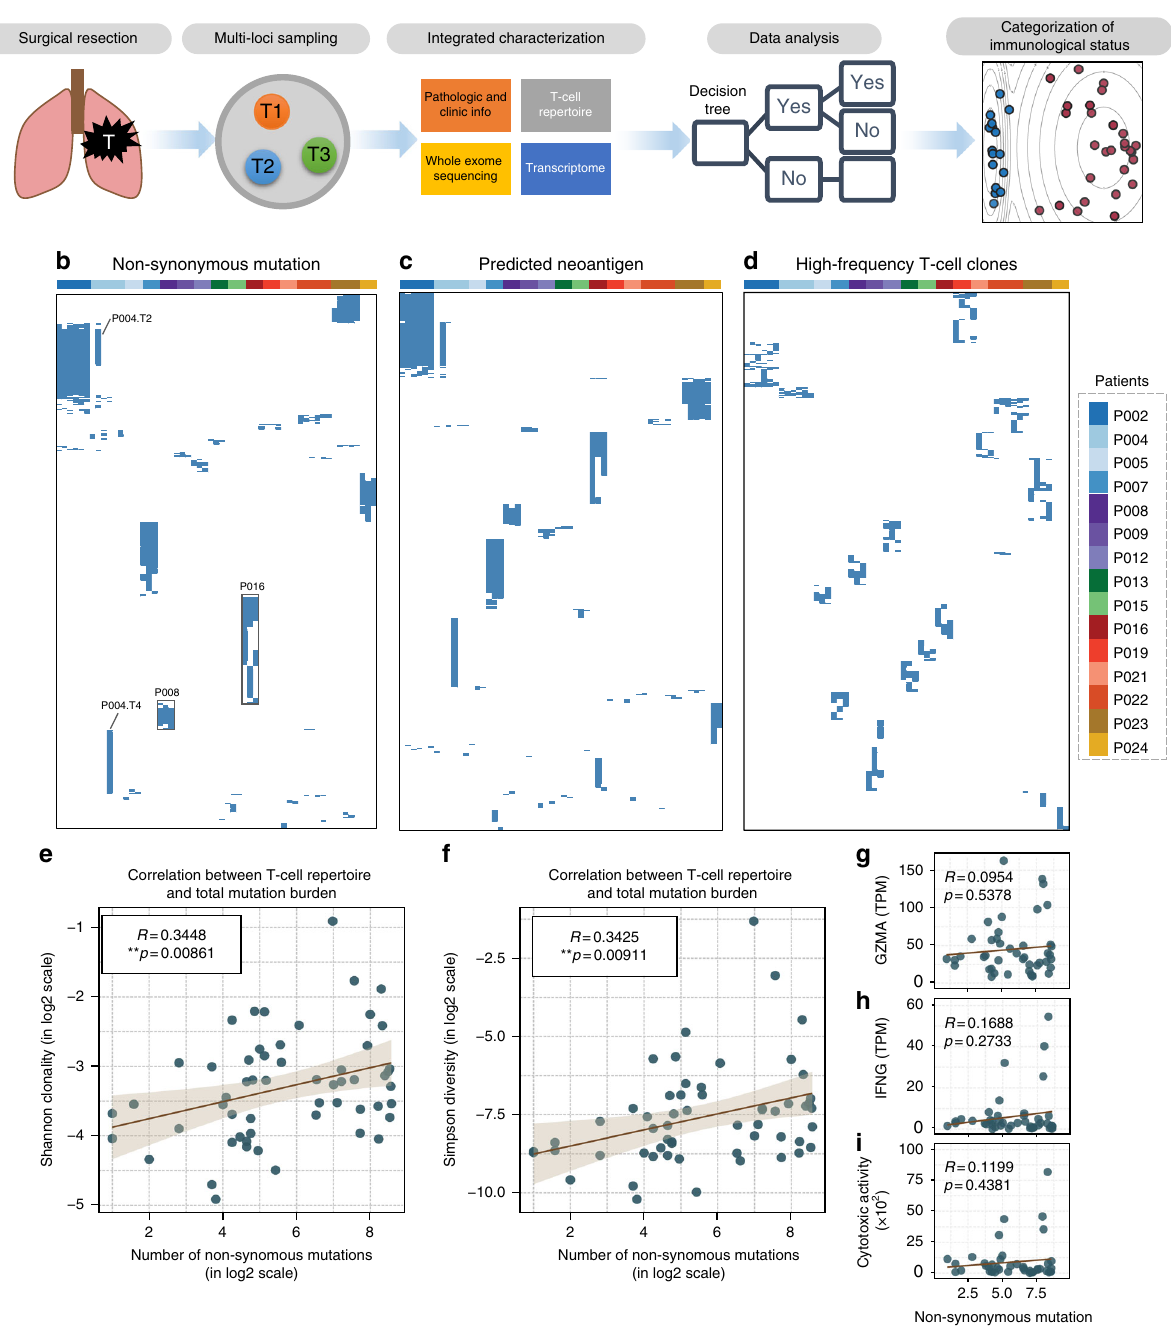
Fig. 1 Total mutational burden correlates with T-cell clonality. a Schematic of sampling strategy and experimental work fl ow. Tissues from multiple loci within the whole tumor were resected and subjected to high-throughput sequencing. Non-synonymous mutations, HLA typing, predicted neoantigens, transcriptomic pro fi ling, and T-cell repertoire were analyzed to characterize TME heterogeneity. b – d Heat maps depicting the inter-population and intratumoral distribution of non-synonymous mutations, predicted neoantigens (with binding strength <500 nM), and dominant T-cell clones (frequencies ≥ 0.5%) in all sequenced subjects; presence (blue) or absence (white) is indicated for every tumor focus. Samples were grouped according to individual patients. e , f Scatterplot showing correlation between total mutation load and expanded properties of the T-cell repertoire. T-cell clonality ( e ) and Simpson diversity index ( f ) were used to depict the T-cell repertoire composition. Enrichment of highly expanded clones results in higher values for clonality and Simpson diversity. R coef fi cient of Pearson's correlation. Shaded area, 95% con fi dent interval for the correlation. g – i Correlation between mutation load (in log2 scale) with expression of interferon-gamma, granzyme-A, and cytolytic activity (measured as the geometric mean of granzyme-A with perforin 1) in log2 of transcript per kilobase million